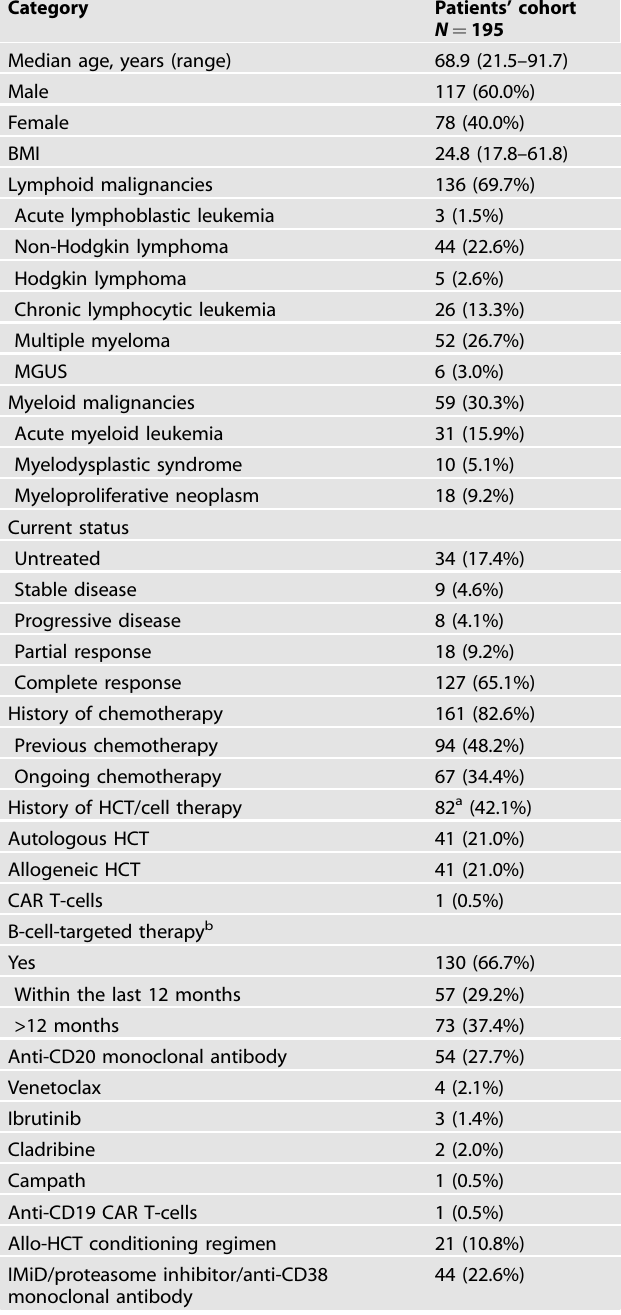
Table 1. Patients ’